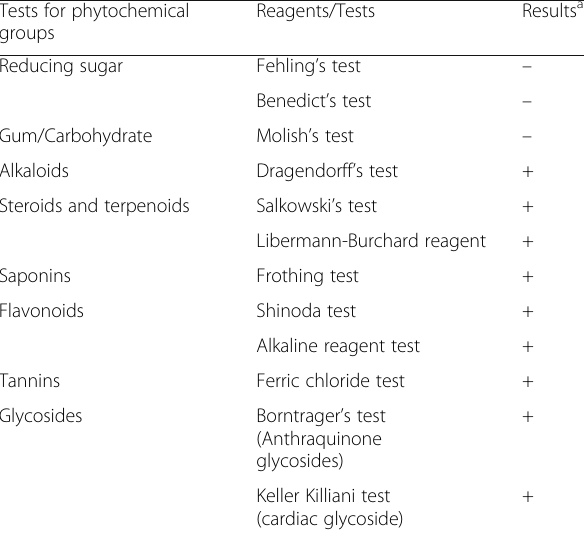
Table 2 Results of phytochemical group test of the